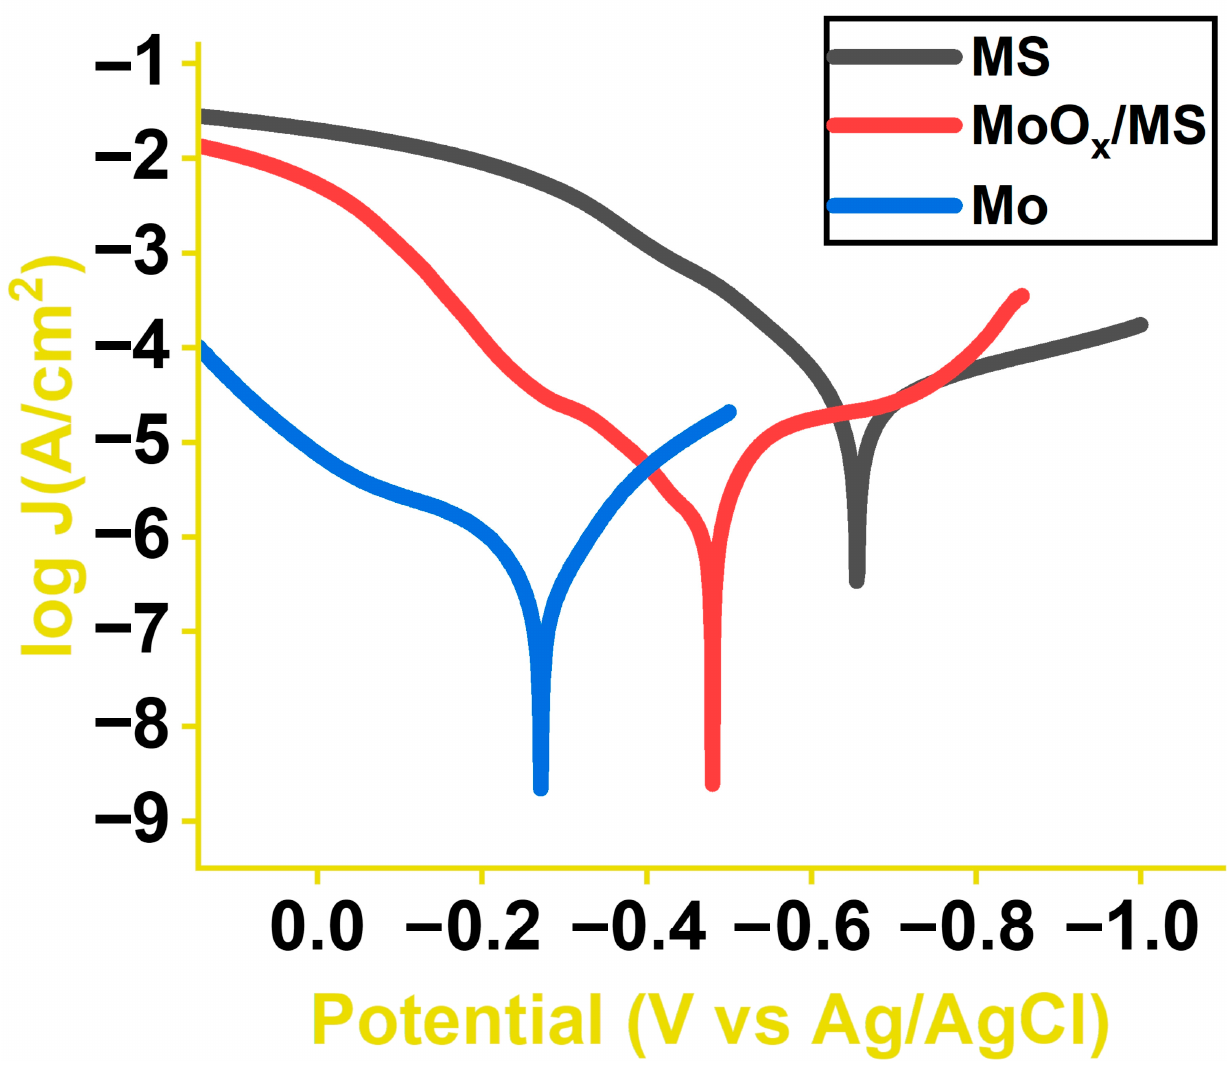
Figure 8. Tafel plots of mild steel, molybdenum oxide deposited over mild steel, and molybdenum foil obtained in 3.5 wt% aqueous NaCl solution.